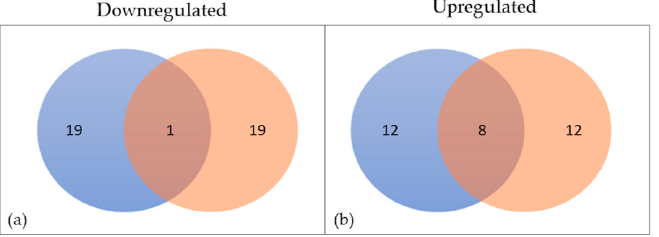
Figure 4. Venn diagrams showing the number of genes downregulated ( a ) or upregulated ( b ) in the two cellular systems; HT22 cells in blue and BV2 in orange.